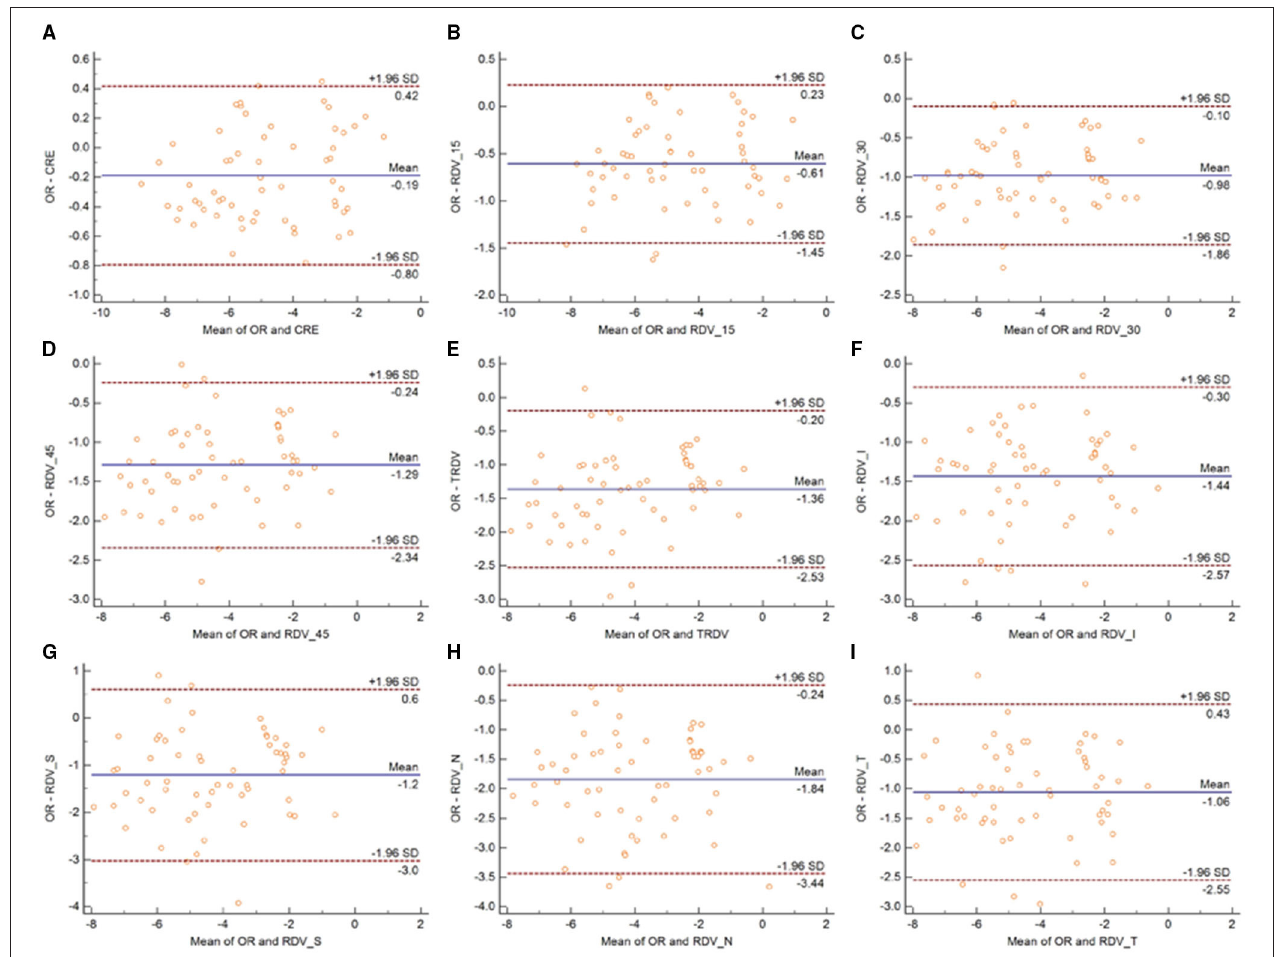
FIGURE 5 | Bland–Altman plots between SR and CRE (A) , RDV-15 (B) , RDV-30 (C) , RDV-45 (D) , TRVD (E) , RDV-I (F) , RDV-S (G) , RDV-N (H) , and RDV-T (I) in cycloplegia eyes. The solid line shows the mean difference (bias), and the upper and lower lines represent 95% limits of